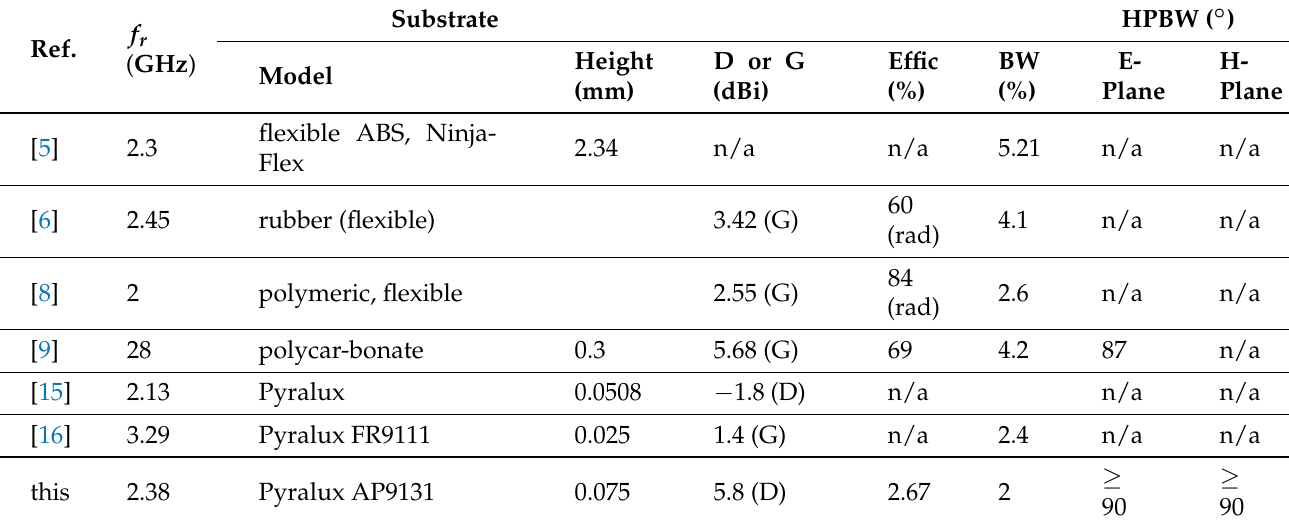
Table 3. Characteristics of some other